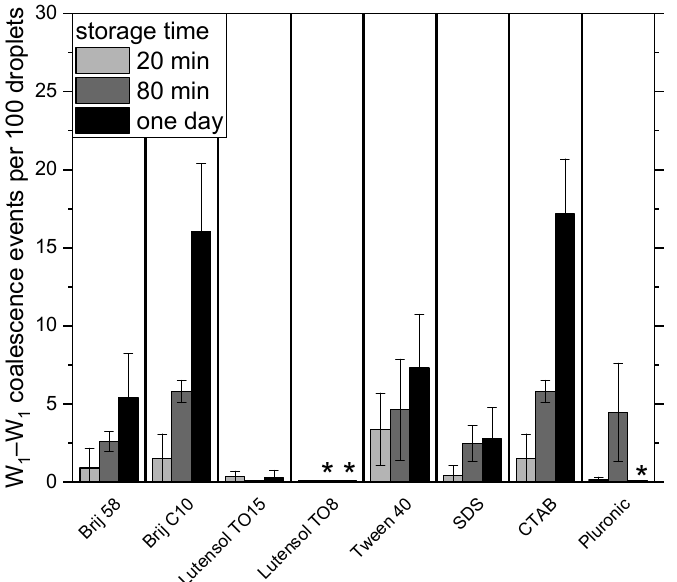
Figure 6. Number of W 1 –W 1 coalescence events normalized to 100 droplets for 0.9 wt% of different hydrophilic surfactants in W 2 and 1 wt% of PGPR in O. Apart from the Lutensol TO15 types, all double emulsions had coalesced inner droplets. The bars marked with an asterisk could not be measured due to major instabilities because of O–O and W 1 –W 2 coalescence.